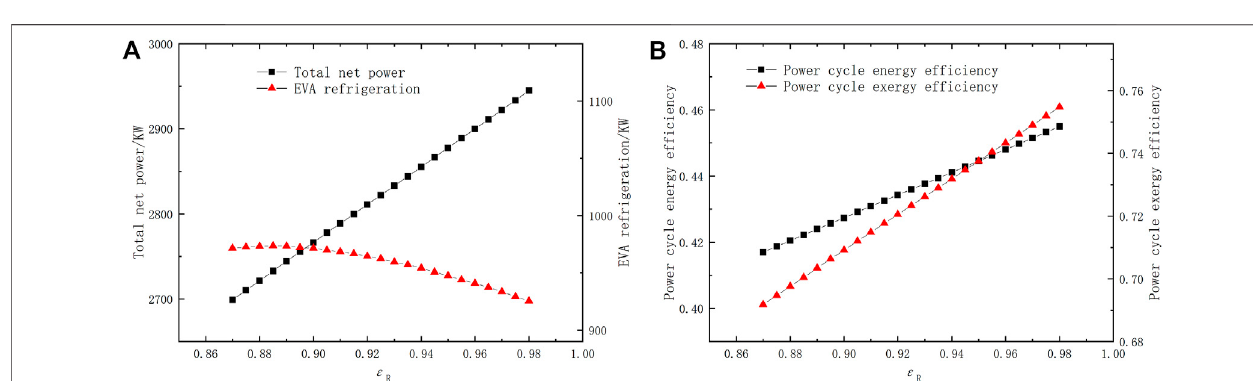
FIGURE 7 | Effect of recuperator effectiveness ε R .